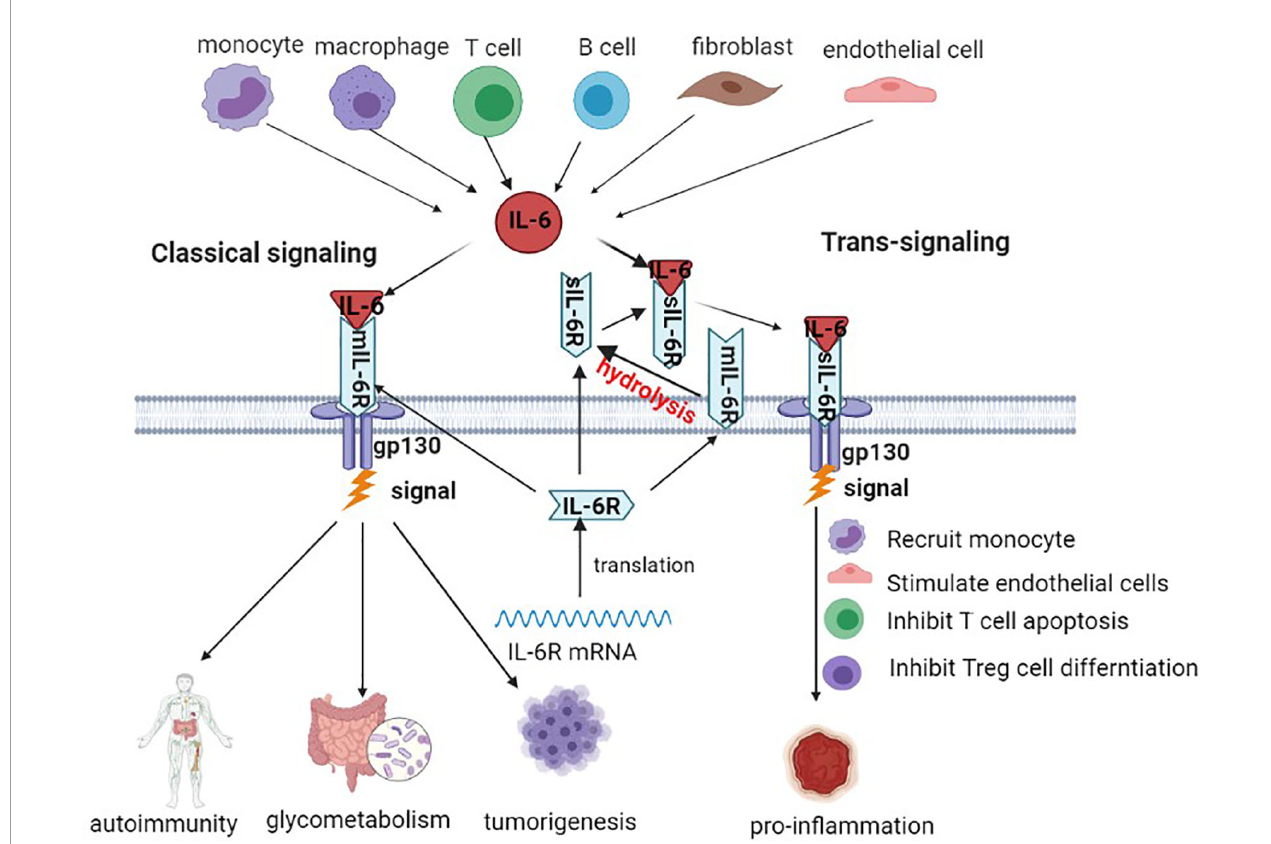
FIGURE 1 | Production source and main signaling pathway of IL-6. IL-6 transduction is mainly produced by monocytes, macrophages, T cells, B cells, fi broblasts, etc. IL-6R binds to the surface of the cellular membrane through the classical pathway. In the signaling transduction pathway, IL-6 binds to sIL-6R and then initiates signaling